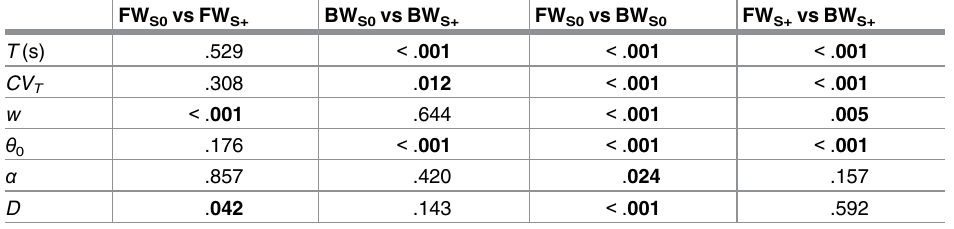
Table 2. Significance level ( p –values)of the post hoc (Holm-Sidak) pairwise multiple comparisons between the different experimental conditions for the parameters analyzed. Statistically significantdif- ferences are written in bold font.